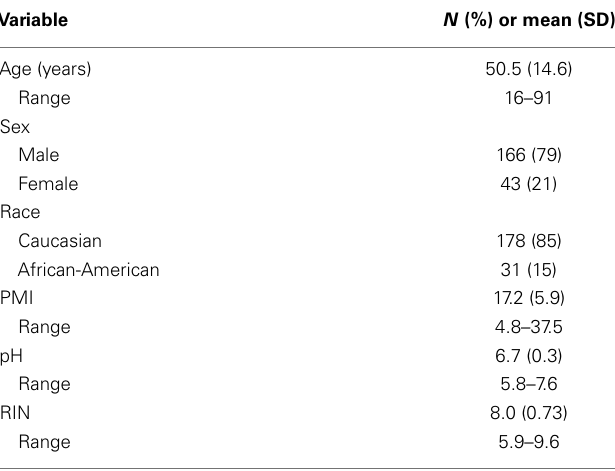
Table 1 | Demographic and technical characteristics of human subjects